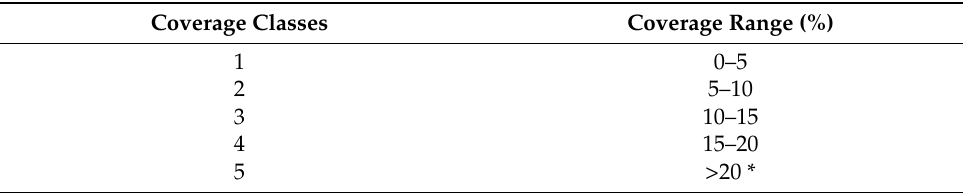
Table 2. Coverage classes and coverage range.